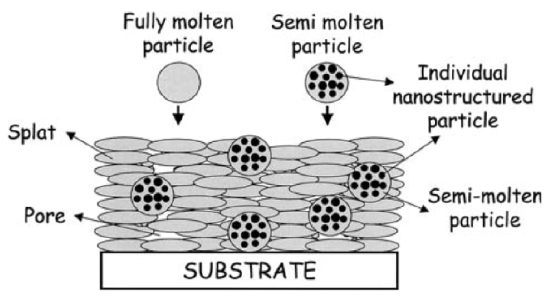
Fig. 78 Typical schematic of nanostructured TBCs with a bimodal structure. Reproduced with permission from Ref. [421], © ASM International 2007.